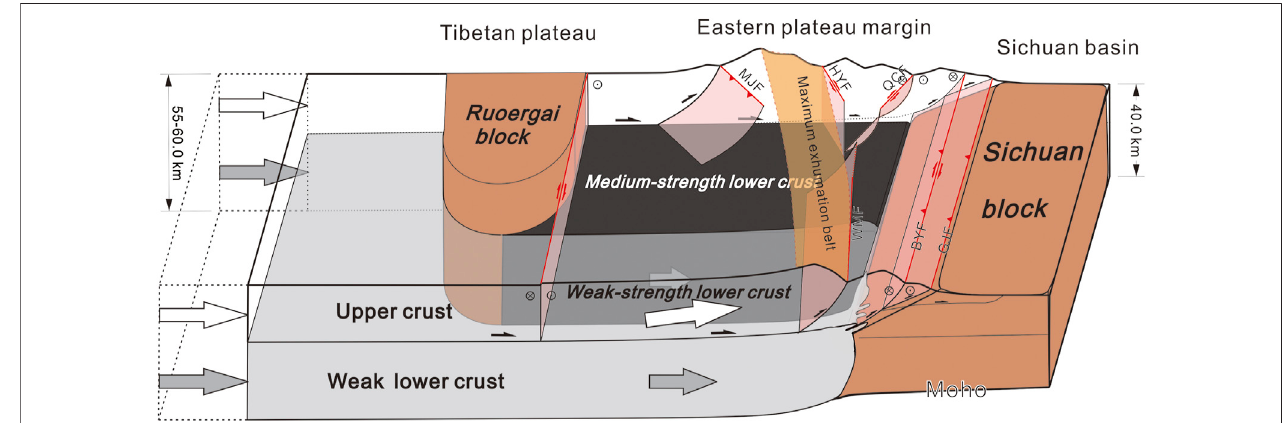
FIGURE10| Ourconceptual tectonic models fortheeasternmargin oftheTibetanplateau crossed theLongmen Shanorogenicbelt.The modelfurther integrates the rigid Ruoergai block, Sichuan block and our simulation results. After imposing a uniform displacement fi eld on the west side of the model, upper and lower crust movementsarepartiallydecoupledneartheSichuanblock.DuetotheweaklayerinthelowercrustsouthoftheBayanHarblock,thelowercrustupliftstheplateaumore in the shortening process of the movement of the Bayan Har block. The red lines indicate the fault traces. The maximum exhumation belt represents the maximum uplift area (Tan et al.,